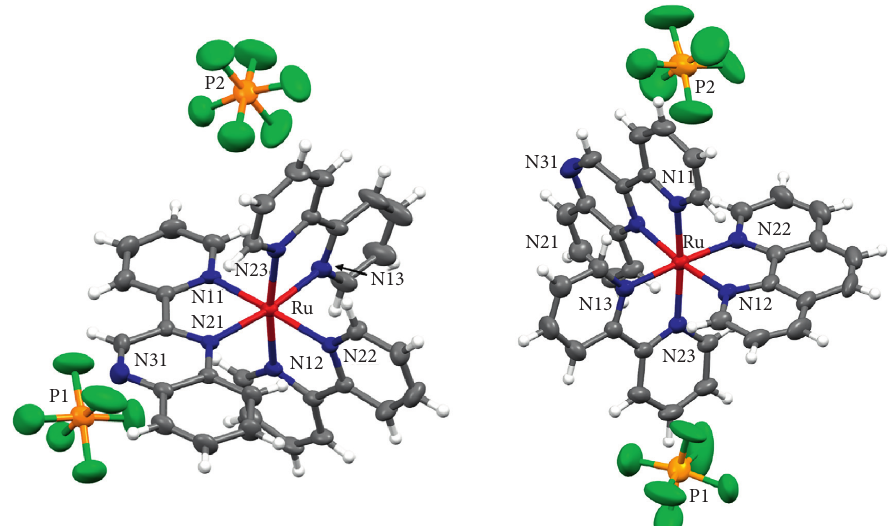
Figure 3: X-ray structures for complexes 1 and 2. Thermal ellipsoids are depicted at the 30% probability level. Solvent molecules of crystallization were omitted for clarity. Table 4: Selected Ru-N bond lengths (˚A).